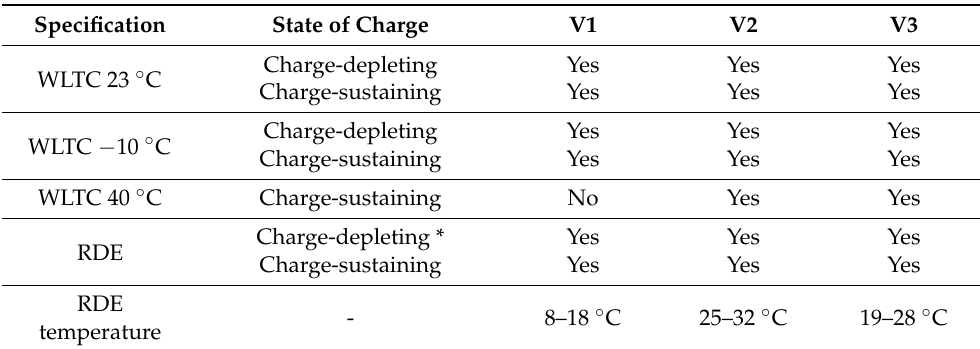
Table 2. Summary of laboratory and on-road